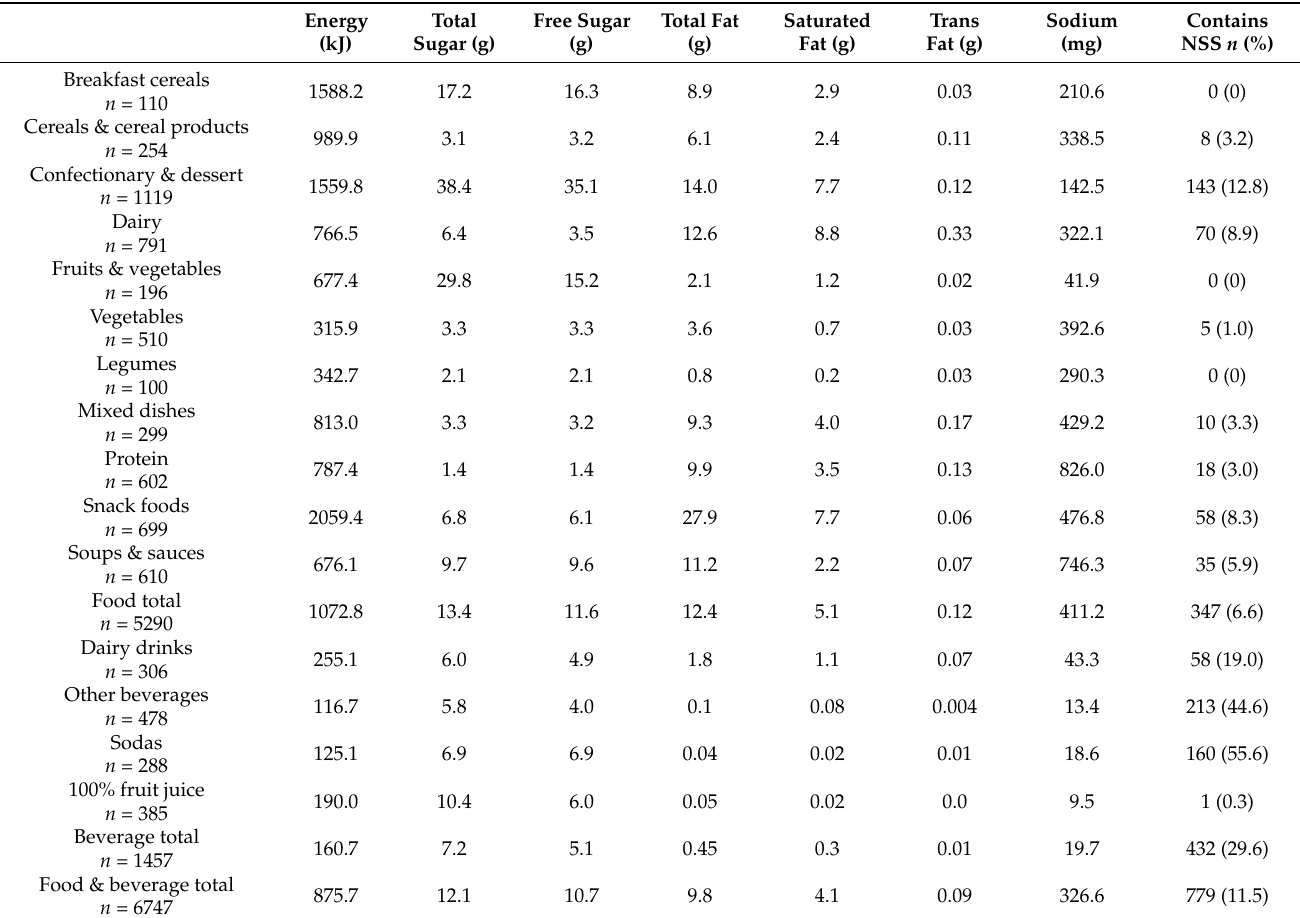
Table 2. Mean content of nutrients of concern in packaged foods in SA per 100 g